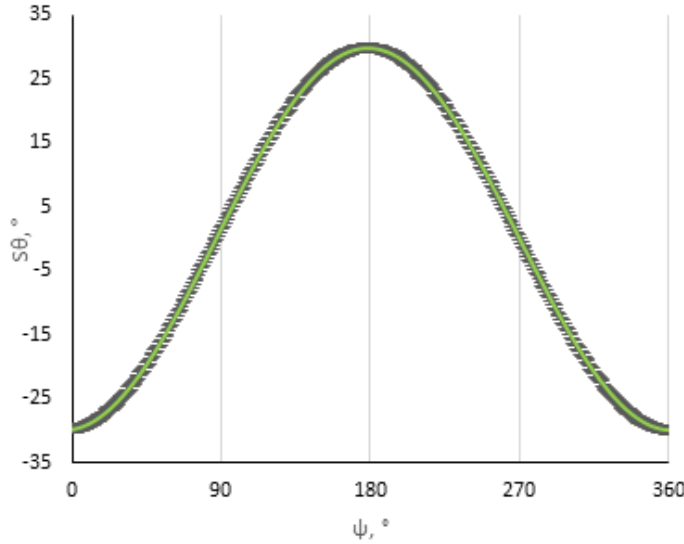
Figure 11. The standard uncertainty of the actual cycloidal function of the CRF.